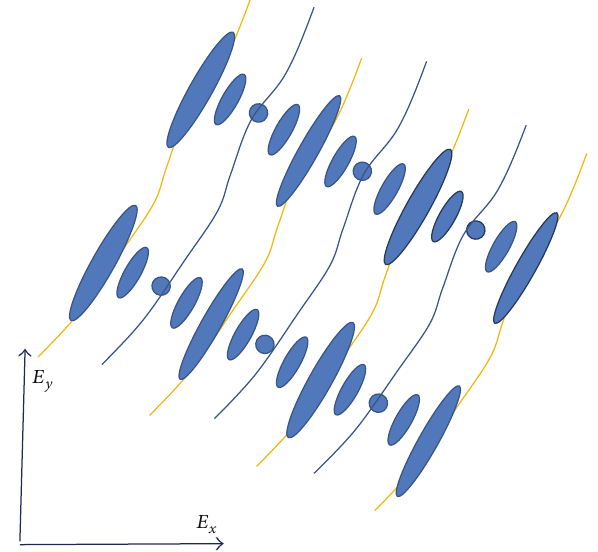
Figure 10: Idealized fingerprint structure, view from the top (com- pared to the central part of Figure 7). Elongated cylinders represent predominant molecular orientation. 𝐸 𝑥 and 𝐸 𝑦 are directions of polarization of incoming and outcoming light. Bright yellow lines correspond to brighter areas in fingerprint structure; dark blue lines correspondtodarkerareaswithhomeotropicmolecularorientation.